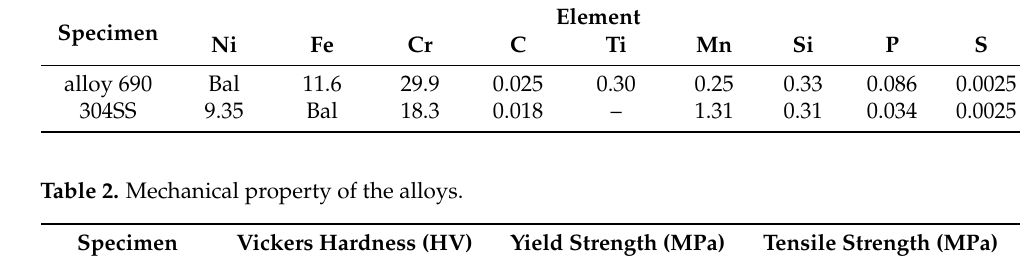
Table 1. Chemical composition of alloys 690TT and 304SS (wt.%).